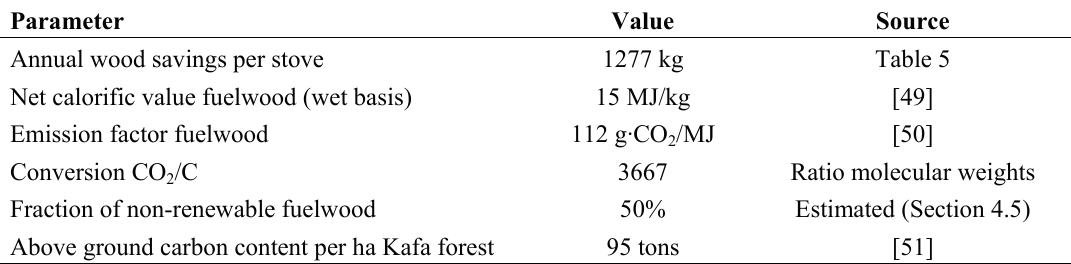
Table 4. Parameters used for calculating carbon